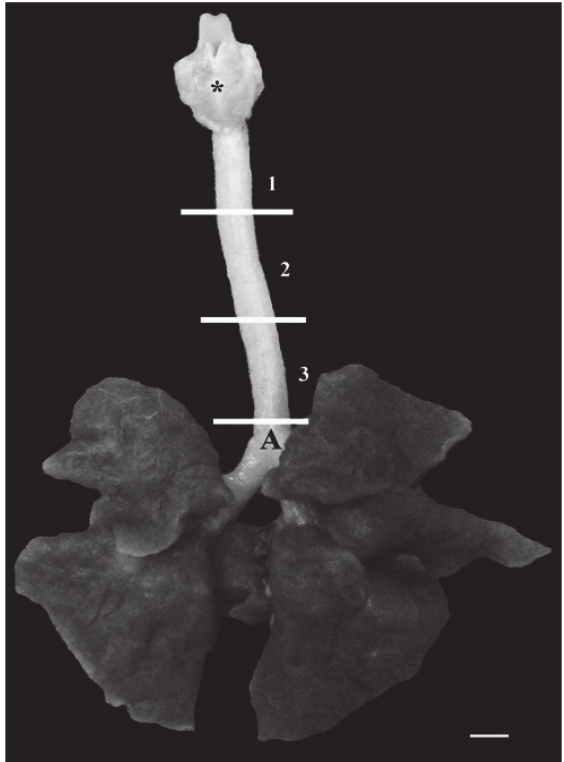
Fig. 1 - Trachea and lung of S. sciureus showing larynx (*), carina (A) and demarcation of the cranial portion (1), middle (2) and caudal (3) portions. Scale bar: